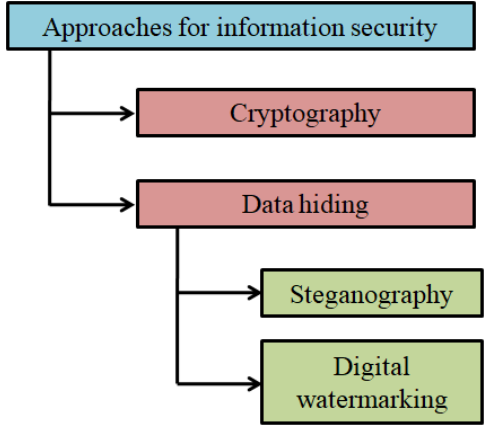
Figure 1. Approaches to information security: an